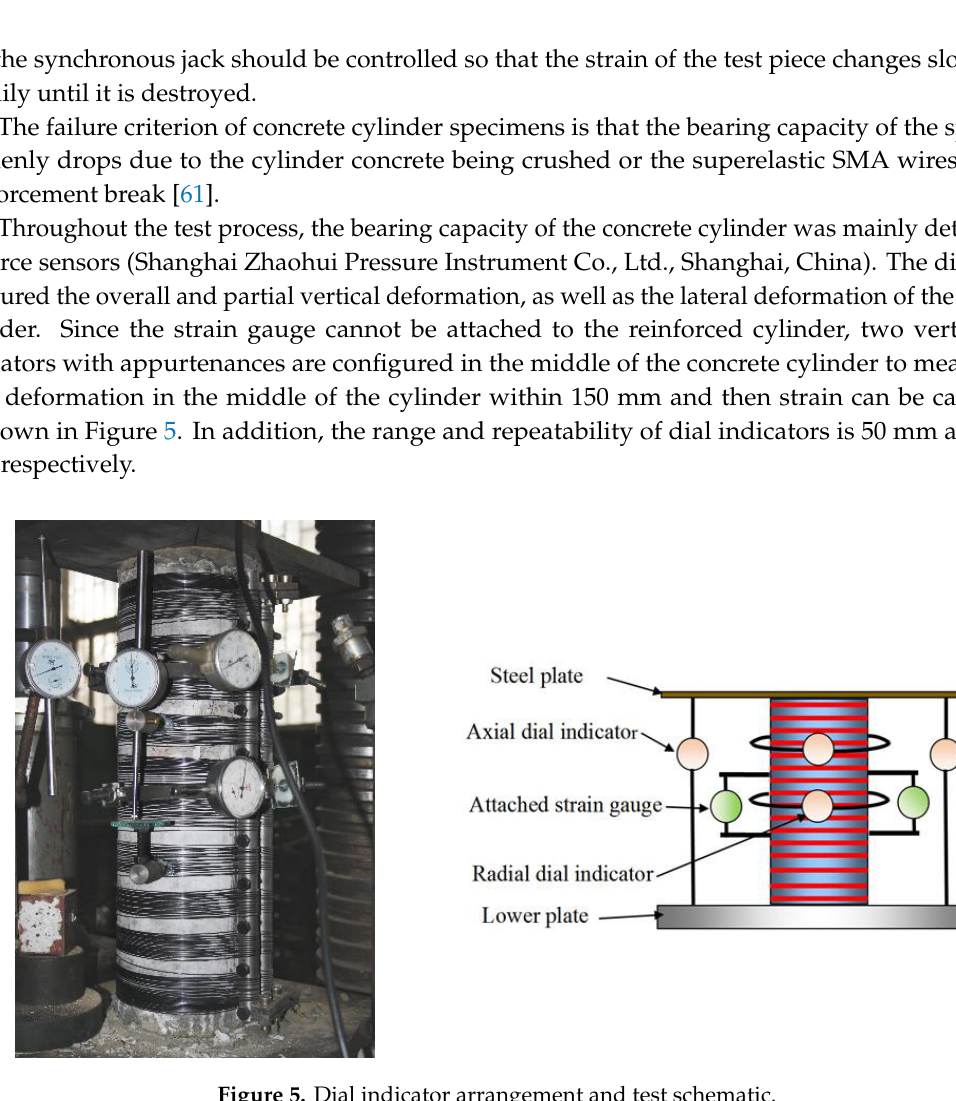
Figure 5. Dial indicator arrangement and test schematic.